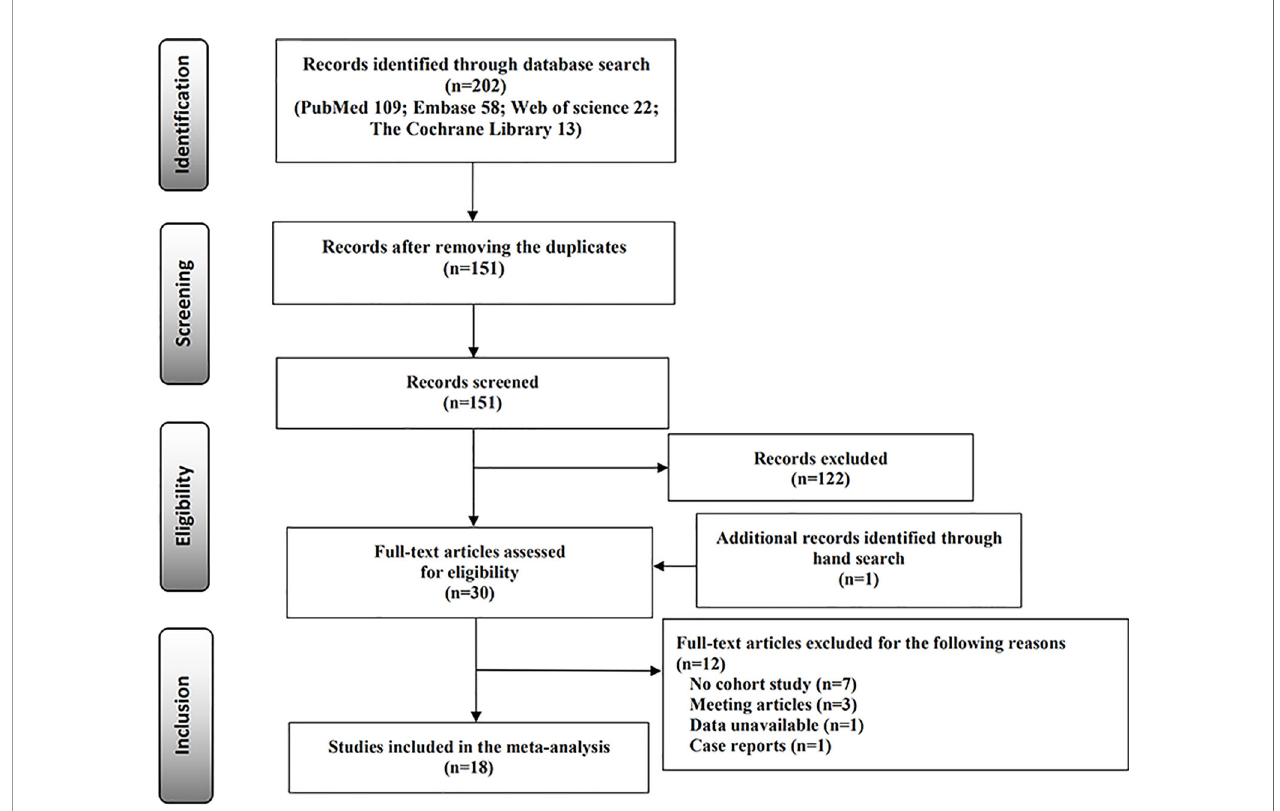
FIGURE 1 | Flow diagram for the selection of the included